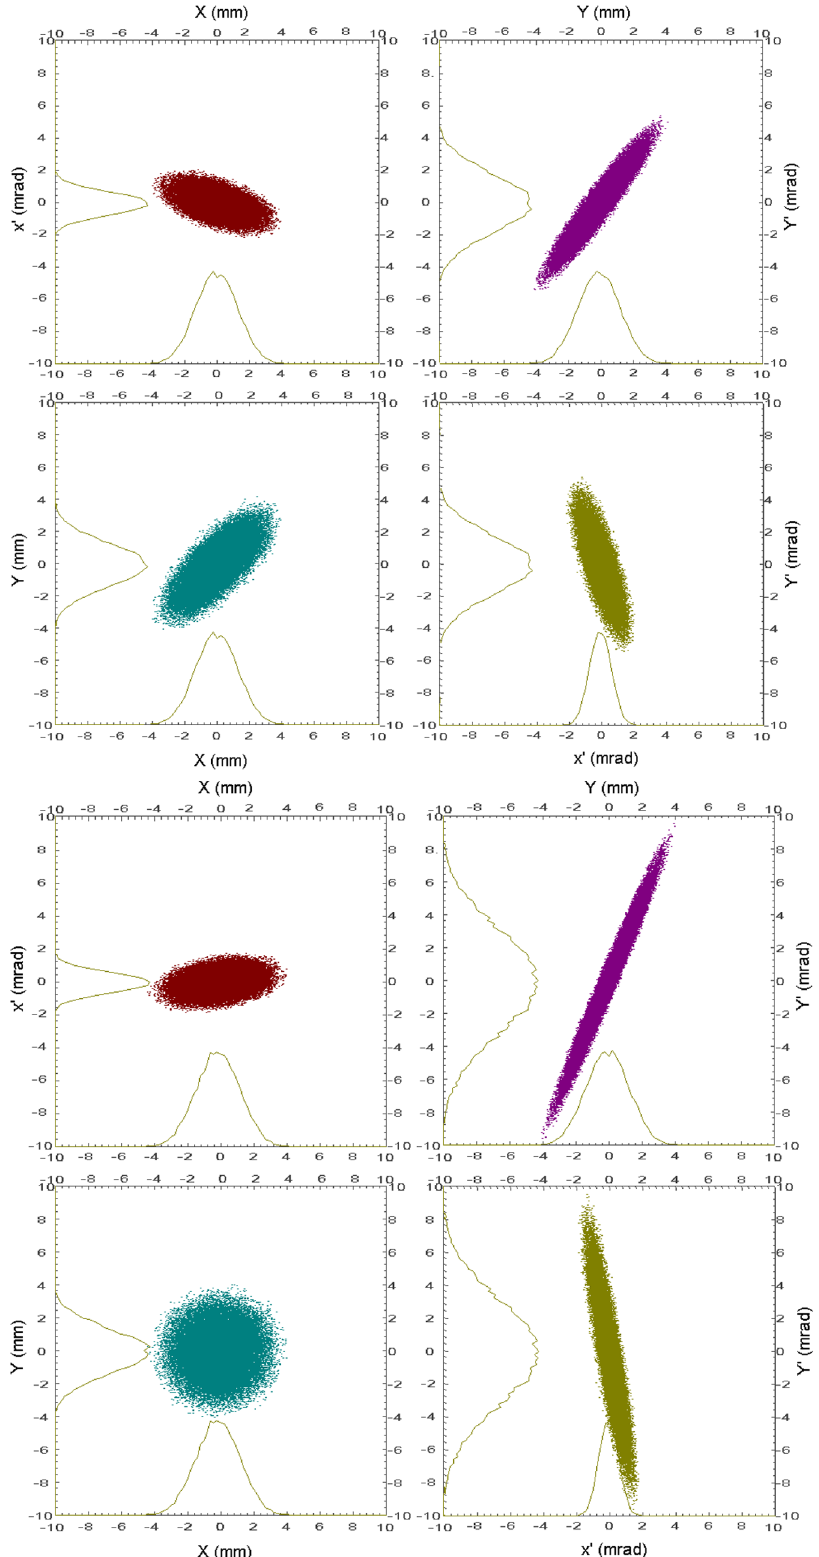
FIG. 5. (Color) Beam distributions in phase spaces at the irradiation spot with a gantry. Upper part: without correction on (cid:6) 13 , the beam spot in ( X - Y ) is a slanted ellipse. Lower part: with correction on (cid:6) 13 using the three quadrupoles after the last bending magnets, the beam spot is round. In both cases, there is (cid:5)